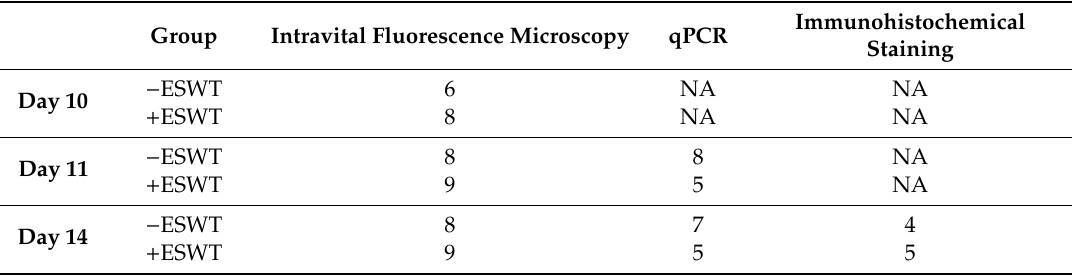
Figure 12. Experimental set-up. ( a ) Seven-day-old chicken embryo. After cutting a small window into the upper part of the eggshell, the window was closed with Parafilm ® , and the eggs were further incubated. The in ovo CAM assay allows direct access to the extraembryonic chorioallantoic membrane via the open window. ( b ) Through the window, the ingrowth of soft tissue and vessels into the porcine-derived CM can be monitored. Table 1. Number of specimens analyzed per group.